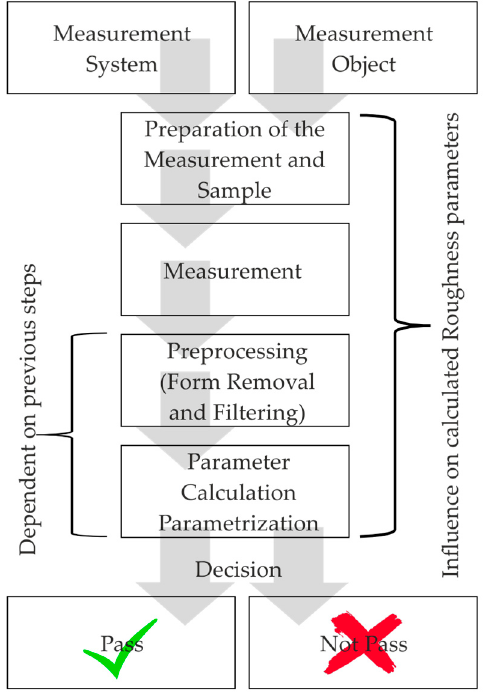
Figure 1. Illustration of steps in roughness parameter calculation.